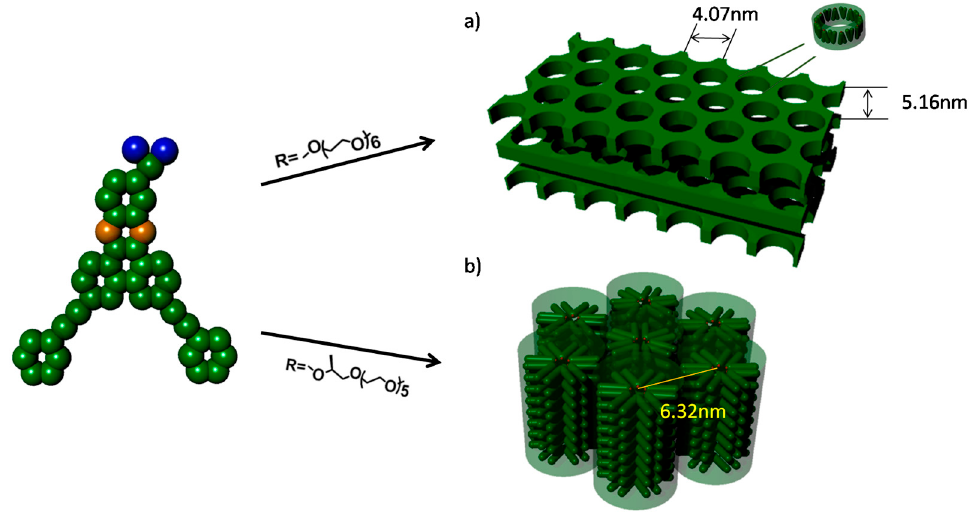
Figure 4. Schematic representation of self-assembly of 1 , 2 in bulk state. ( a ) A hexagonal perforatedlamellar structure of 1 ; ( b ) A hexagonal columnar structure of 2 , PEO chains are omitted for clarity.